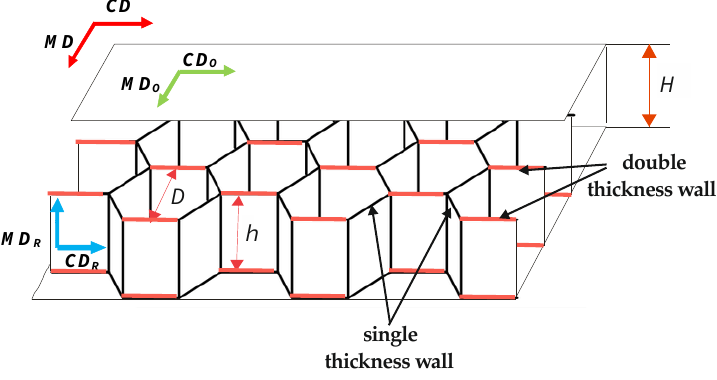
Figure 2. Construction of a cellular cardboard with a honeycomb core.